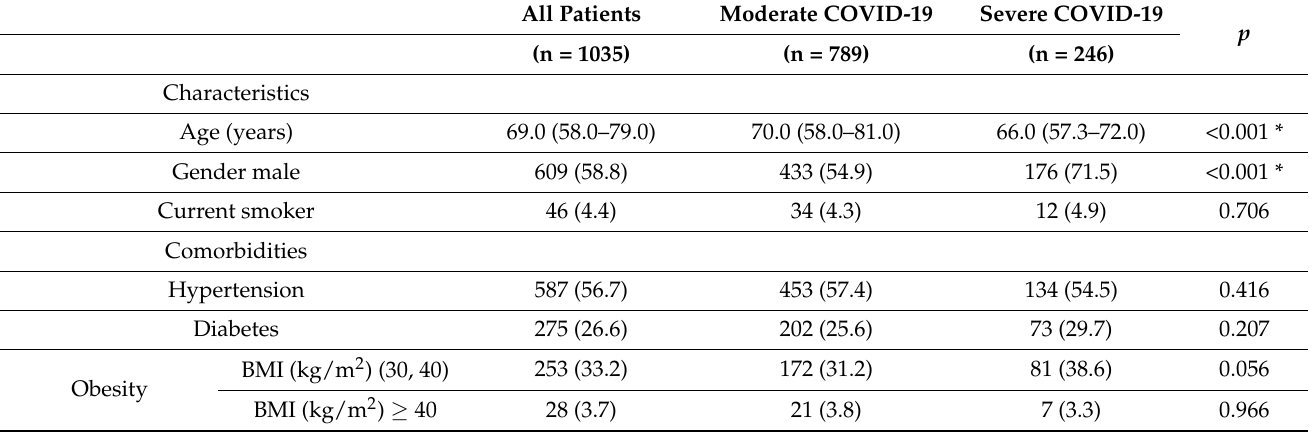
Table 1. General characteristics, comorbidities and laboratory findings of study population with moderate and severe